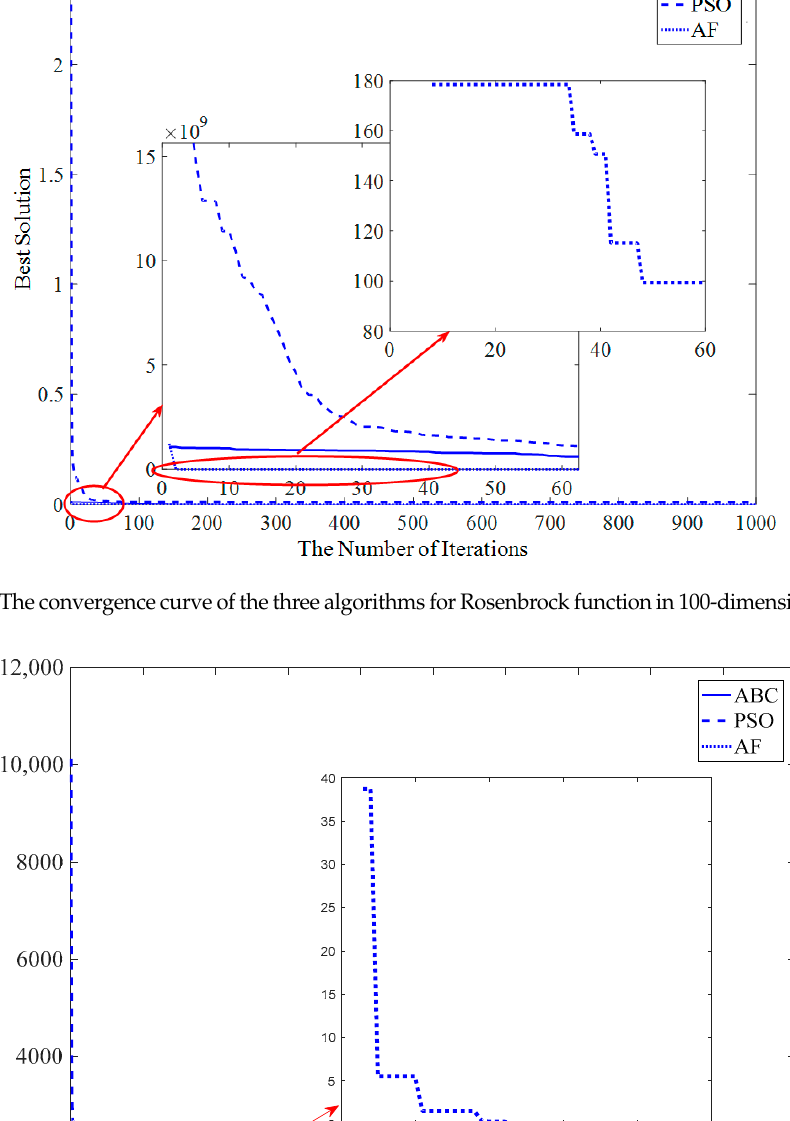
Figure 15. The convergence curve of the three algorithms for Sphere function in 100-dimensional space.